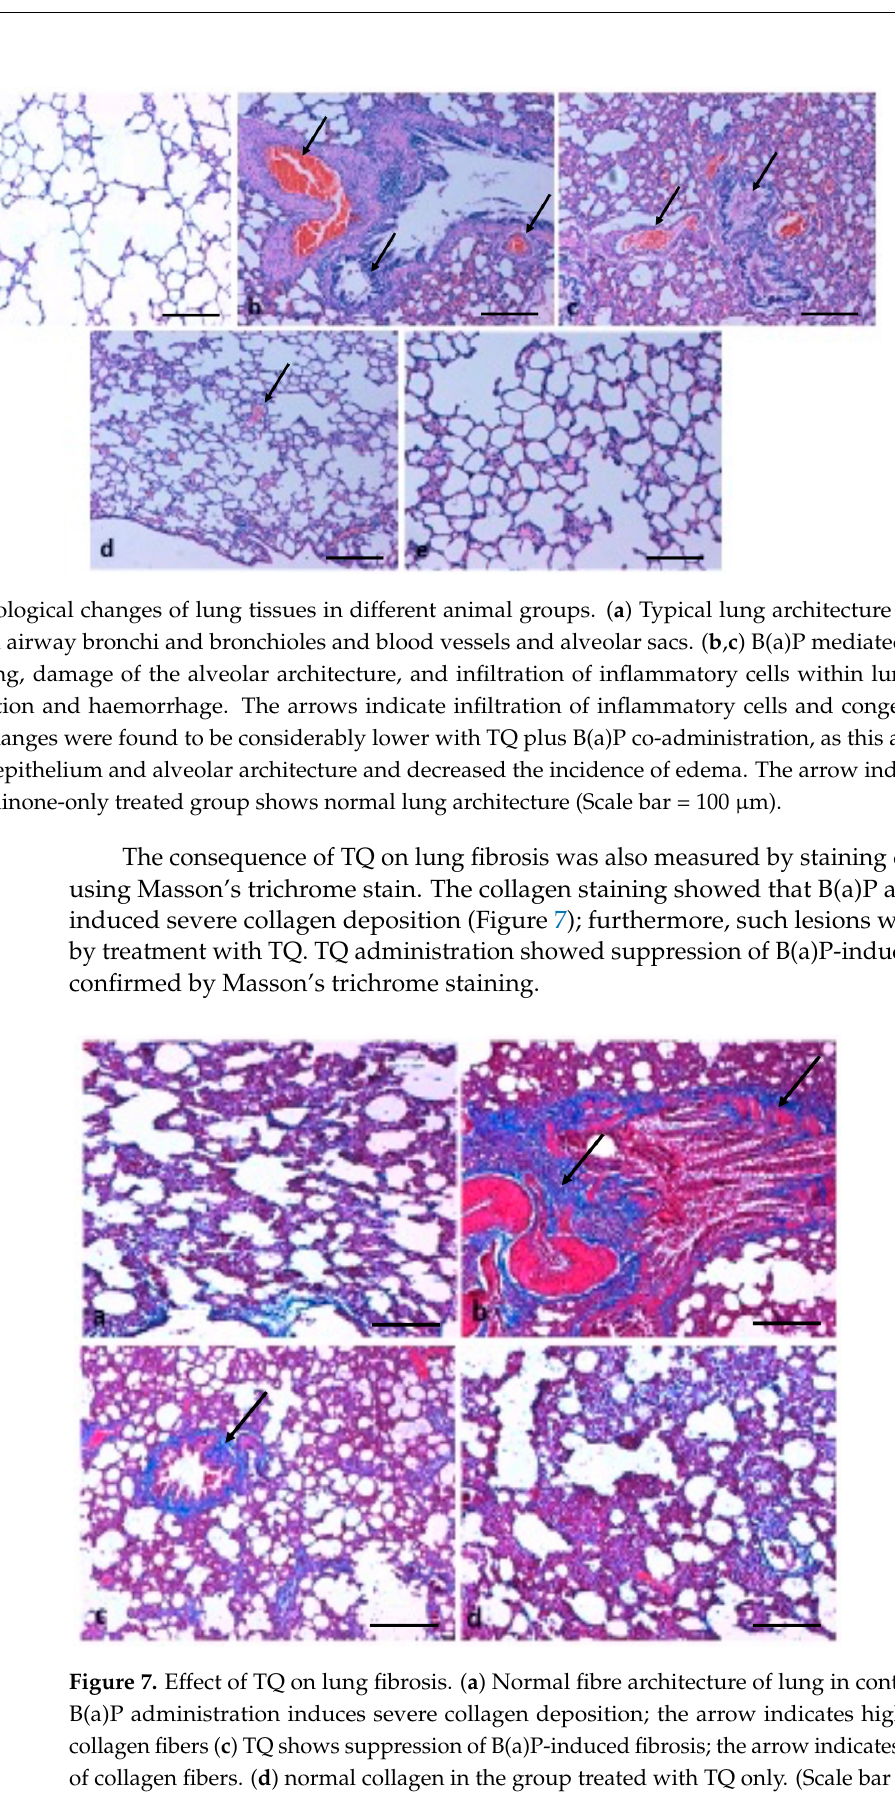
Figure 7. Effect of TQ on lung fibrosis. ( a ) Normal fibre architecture of lung in control animals; ( b ) B(a)P administration induces severe collagen deposition; the arrow indicates high deposition of collagen fibers ( c ) TQ shows suppression of B(a)P-induced fibrosis; the arrow indicates less deposition of collagen fibers. ( d ) normal collagen in the group treated with TQ only. (Scale bar = 100 μ m.)